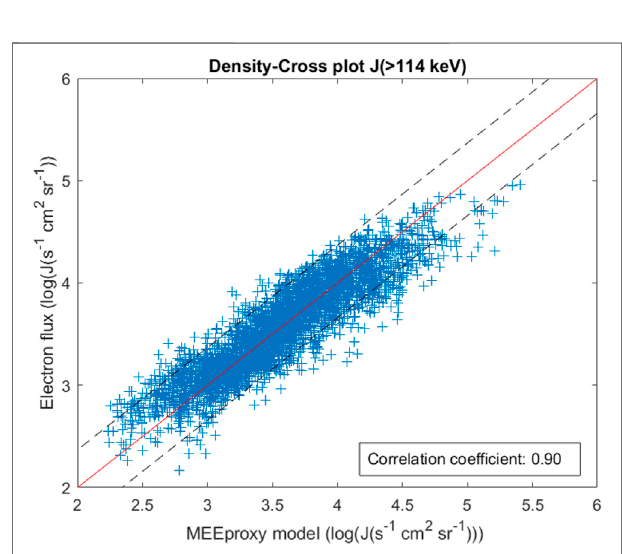
FIGURE 9 | Scatter plot of a linear fi t of the logarithmic value of the optimized MEE proxy and logarithmic value of the daily > 114 keV fl uxes. The black, dashed lines show the 95 and 5 percentile of the model errors.